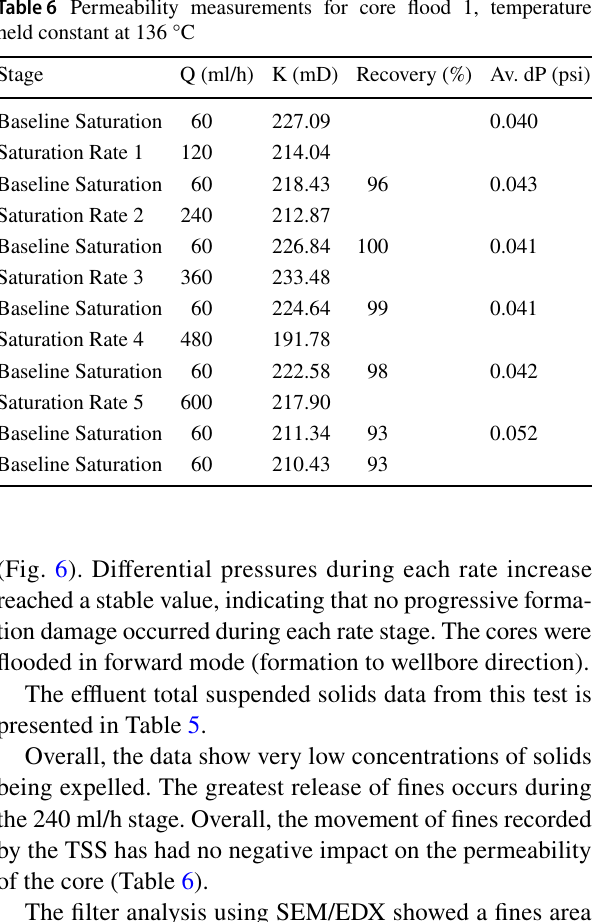
Table 6 Permeability measurements for core flood 1, temperature Table 7 Permeability measurements for core flood 2,